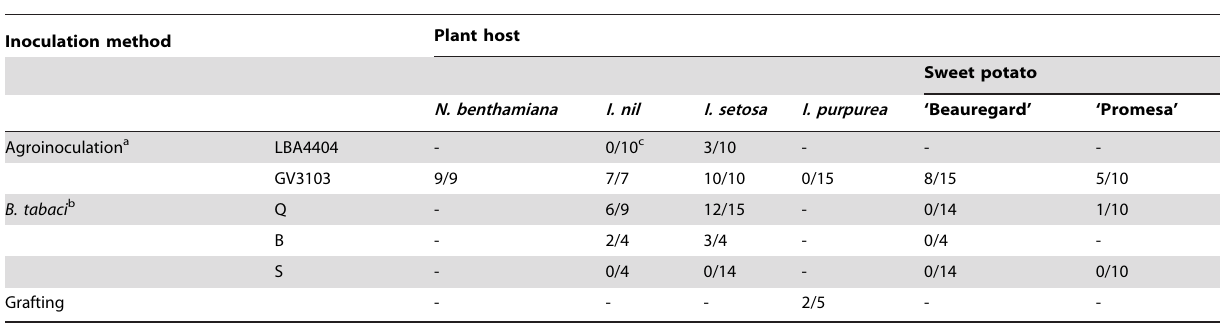
Table 1. Transmission experiments with